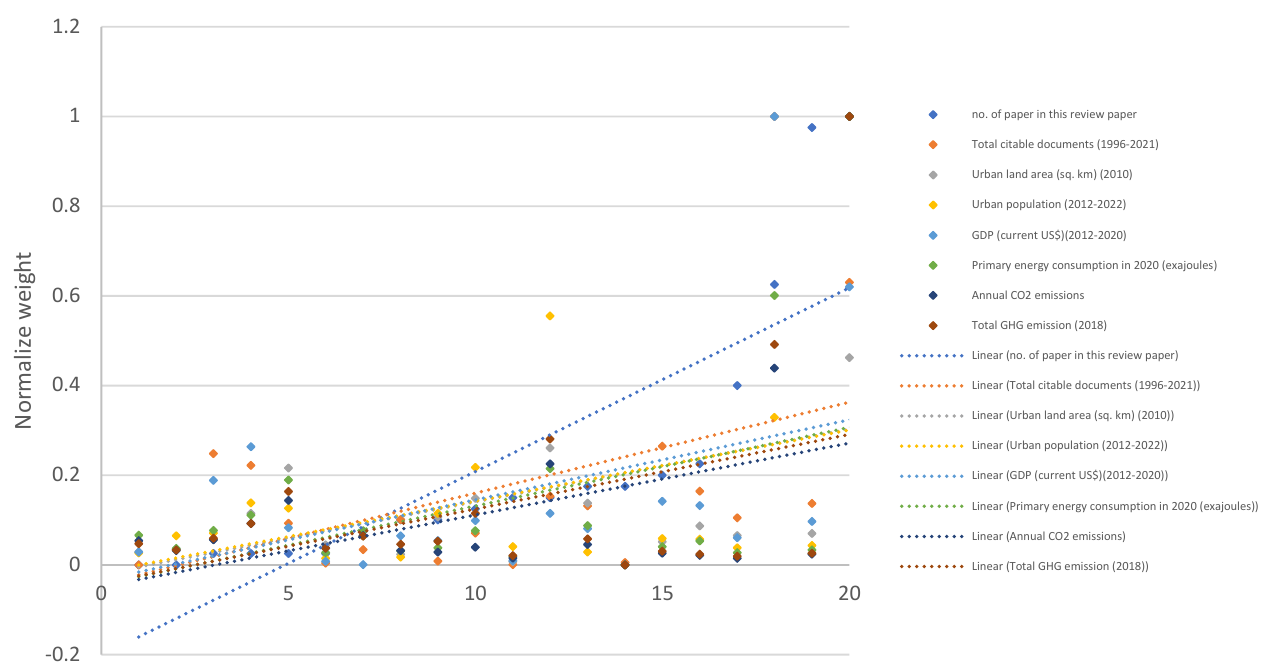
Figure 8. The normalized weight of the socioeconomic factors.